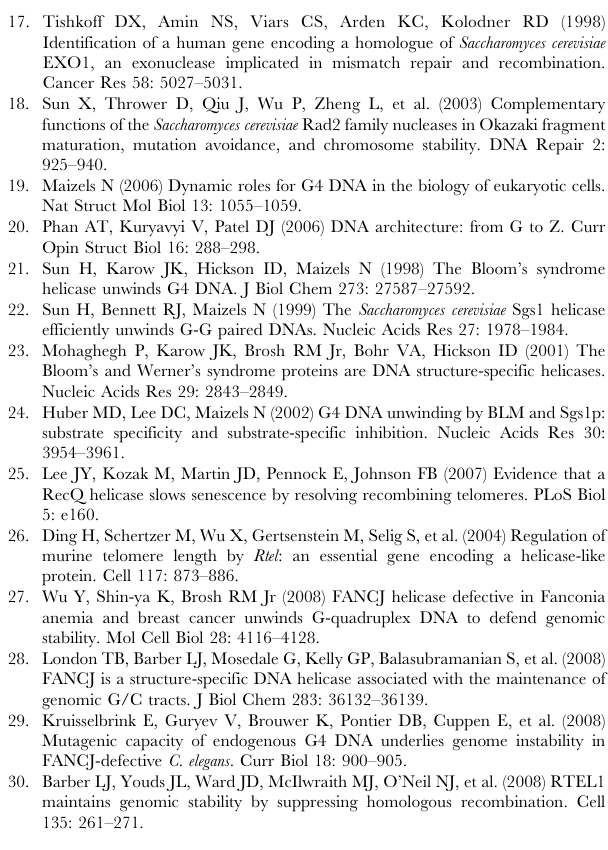
Figure S1 Structure formation by substrates. (A) Substrates diagrammed on left were analyzed by electrophoresis on a native gel containing 10 mM KCl. Substrates were 3 9 end-labeled either opposite the tail or at the nick; asterisk denotes end-label. Retarded mobility on a native gel containing 10 mM KCl is diagnostic of G4 DNA formation by substrates b and e (arrow). (B) Substrates diagrammed on left (asterisk denotes 5 9 -end-label) were gel purified, and structure formation confirmed by electrophoresis on a native gel containing 10 mM KCl. Substrates bearing an unstructured 5 9 -flap (a) migrated more rapidly than substrates containing telomeric G4 DNA 5 9 flap (b) or 3 9 tail (c). These substrates (indicated by arrows) were used for subsequent